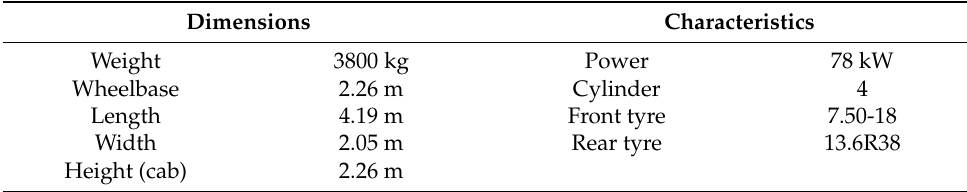
Table 2. Characteristics of the